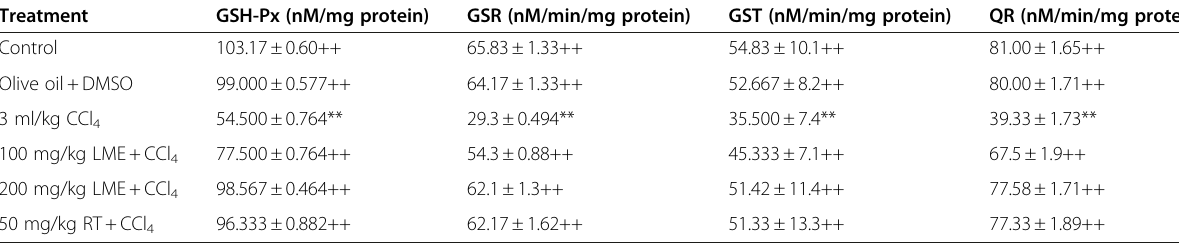
Table 1 Effect of LME on lungs GSH-Px, GSR, GST and QR Treatment